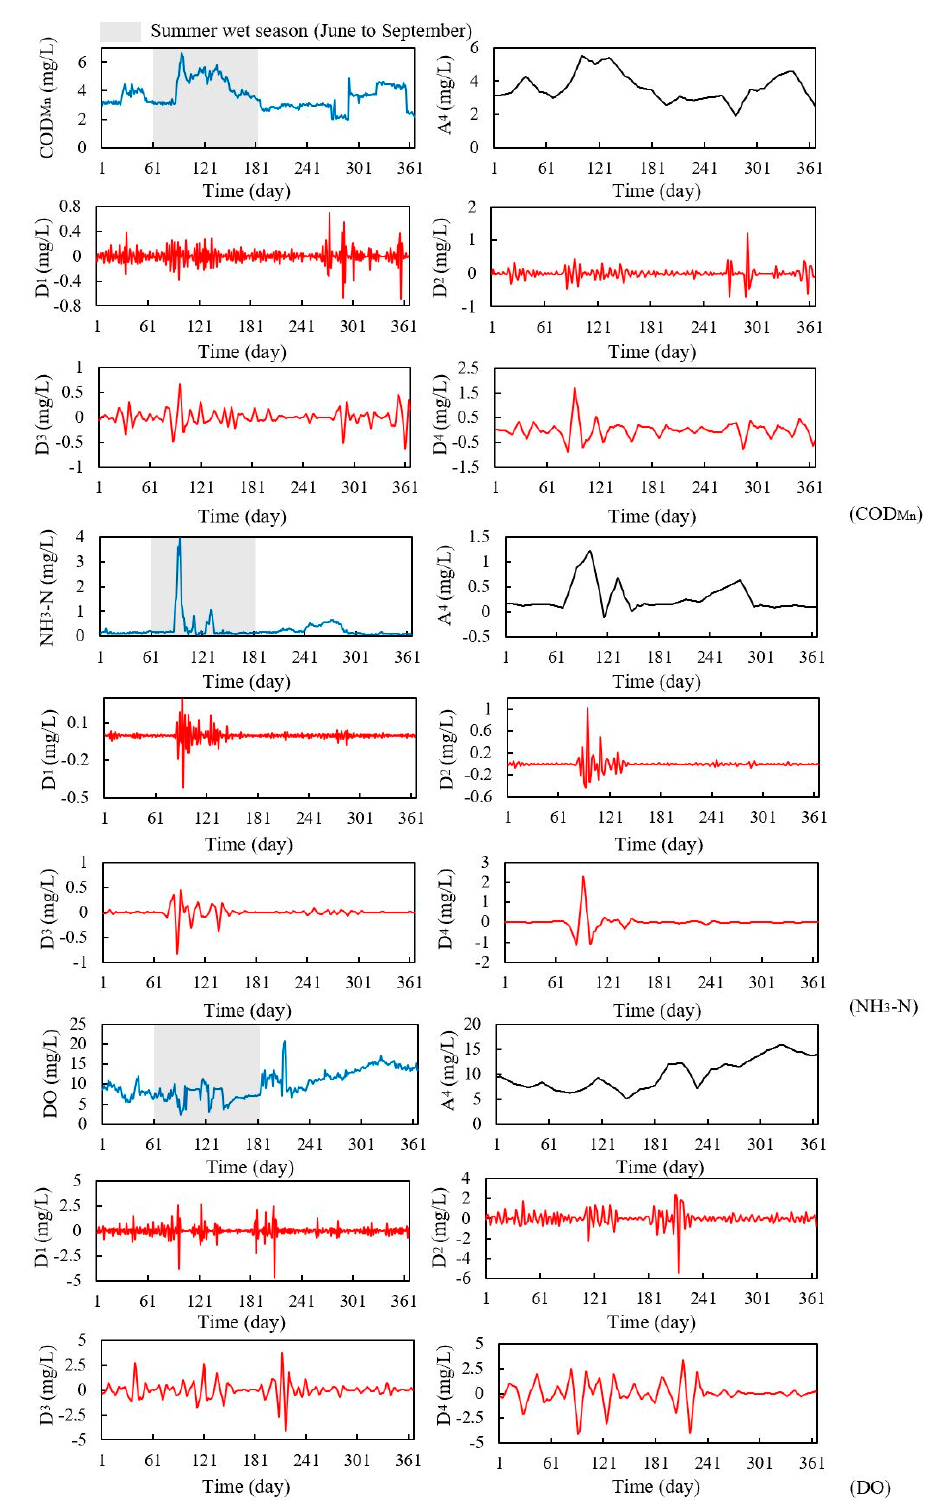
Figure 4. Approximation and detailed sub-series of daily data using a db3 based on layer 4.